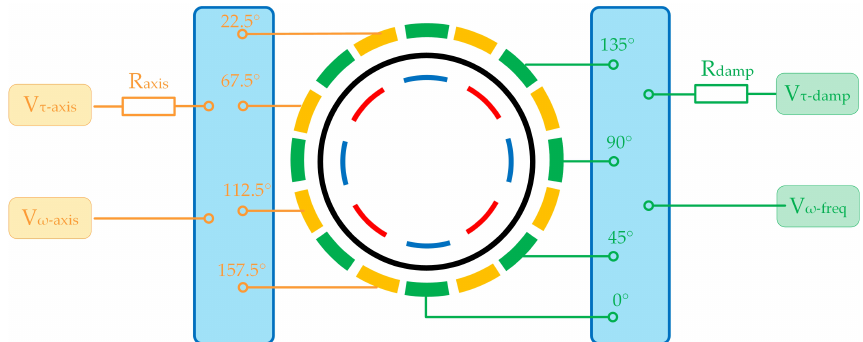
Figure 6. The schematic diagram of the connection between the tuning electronics and voltage